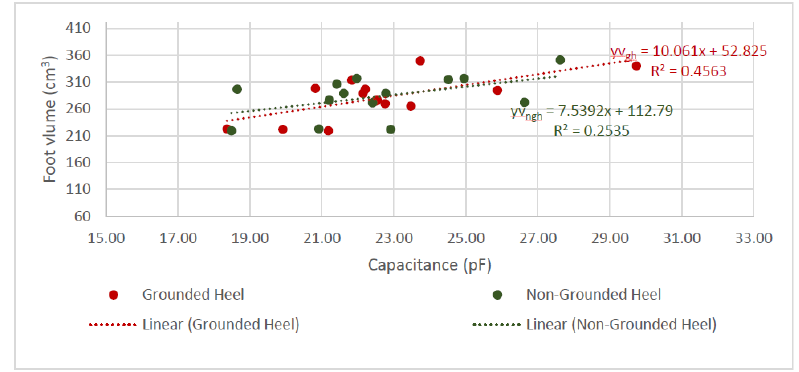
Figure 27. Graph of Foot Volume and Capacitance.